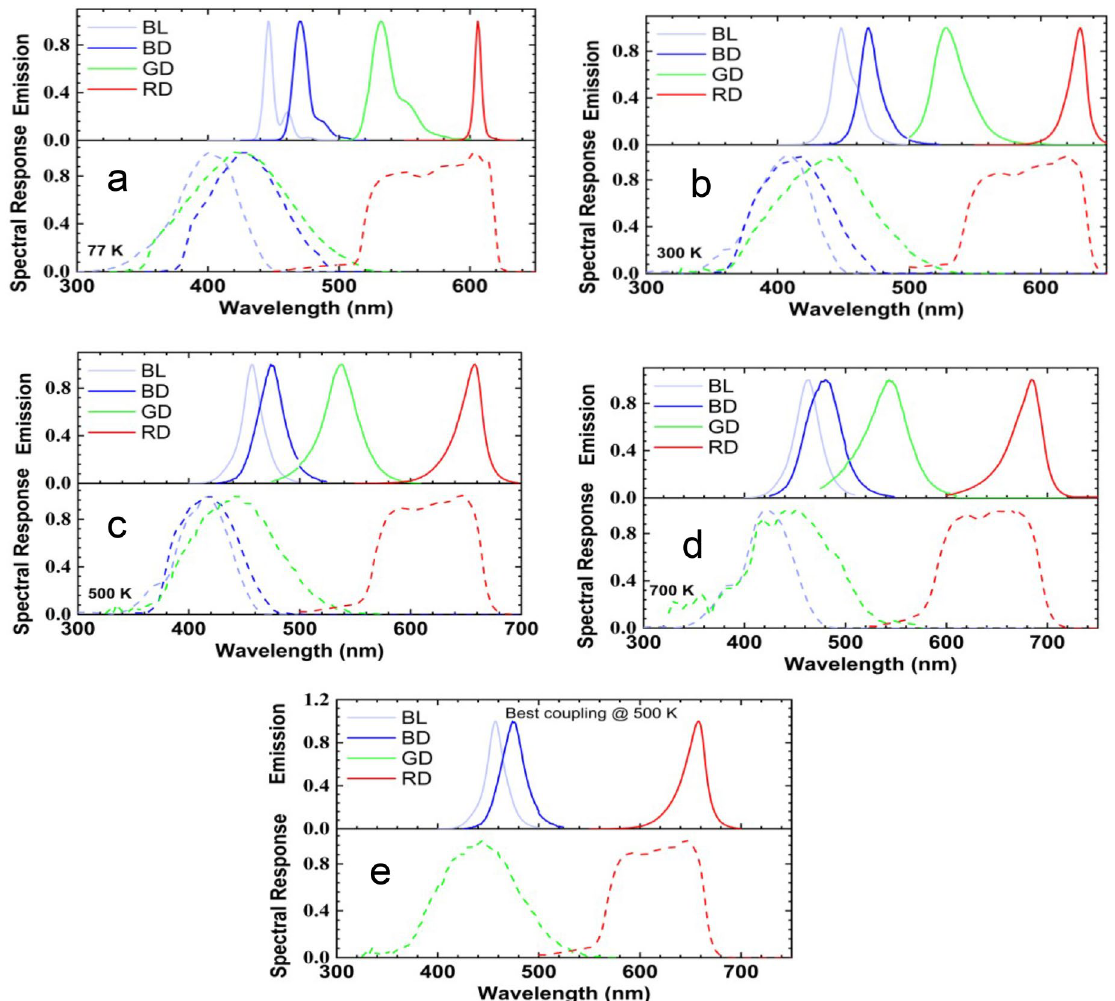
Figure 5. Four LEDs’ normalized emission spectra (solid) and spectral responses (dots) at ( a ) 77 K, ( b ) 300 K, ( c ) 500 K, ( d ) and 700 K. ( e ) Normalized emission and spectral response for selected LEDs for targeted high- temperature